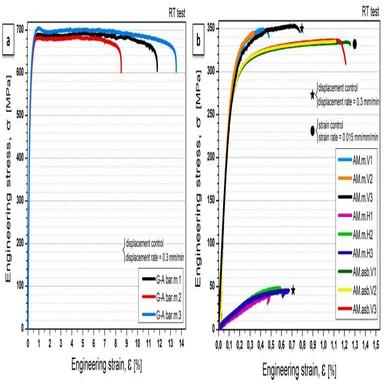
Static engineering stress-strain curves at Room Temperature for (a) specimens obtained from Plansee bar; (b) specimens produced via LPBF in different direction (Vertical and Horizontal) and with different post processing (machined and as built).